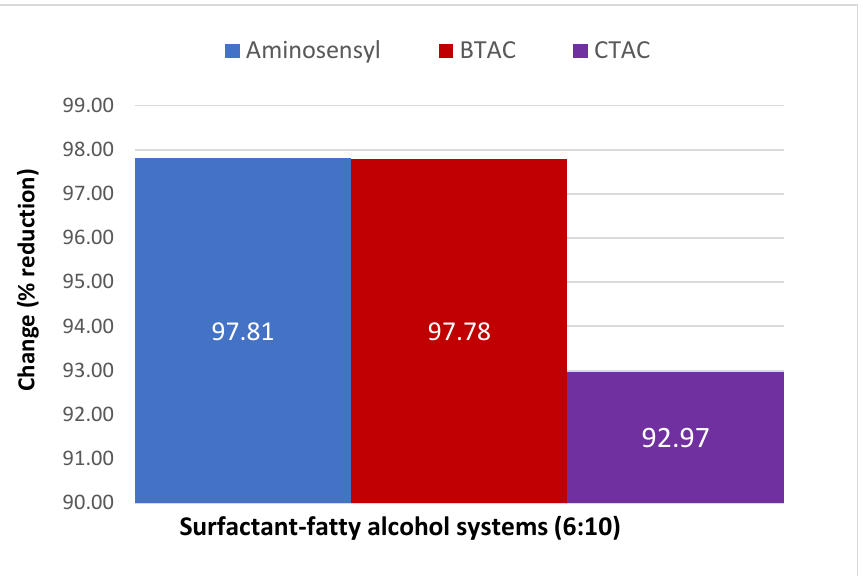
Figure 3. Percentage reduction in combing force after conditioner application.